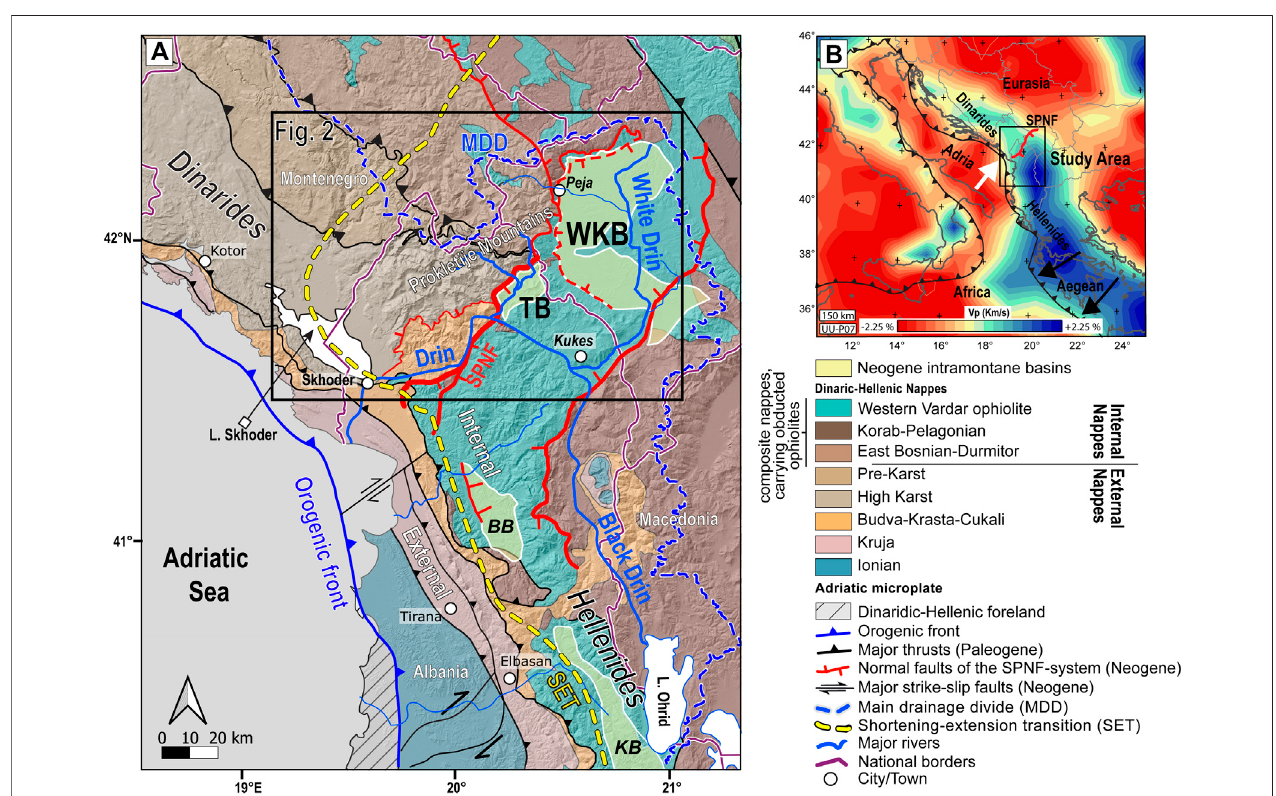
FIGURE 1 | Overview maps: (A) Tectonic map of the junction between the southern Dinarides and northwestern Hellenides. Faults and main nappe units are modi fi edafterSchmidetal.,2008).Bluelines-branchesoftheDrinRiver.Thickdashedyellowline – present-daytransitionfromongoingshorteningtoongoingextension (SET) after Jouanne et al. (2012). Thick dashed blue line – main drainage-divide (MDD). Outlined box indicates the area of Figure 2 . TB – Tropoja Basin, WKB – Western KosovoBasin,SPNF-Shkoder-PejaNormalFault,BB – BurrelBasin,KB – KorçaBasin.ShadedreliefbasedonSRTM-1arc-secondDEM(NASA,2013); (B) Mapof teleseismic P-wave anomalies at 150 km depth of the southeastern Mediterranean area. P-wave tomography is from Hall and Spakman, 2015, their UU-P07 model). Whitearrow – motionofAdriarelativetoEurasia.Blackarrows – motionoftheHellenicorogenicfrontwithrespecttoEurasiasince~15 MaduetoretreatoftheAdriaticslab beneath the